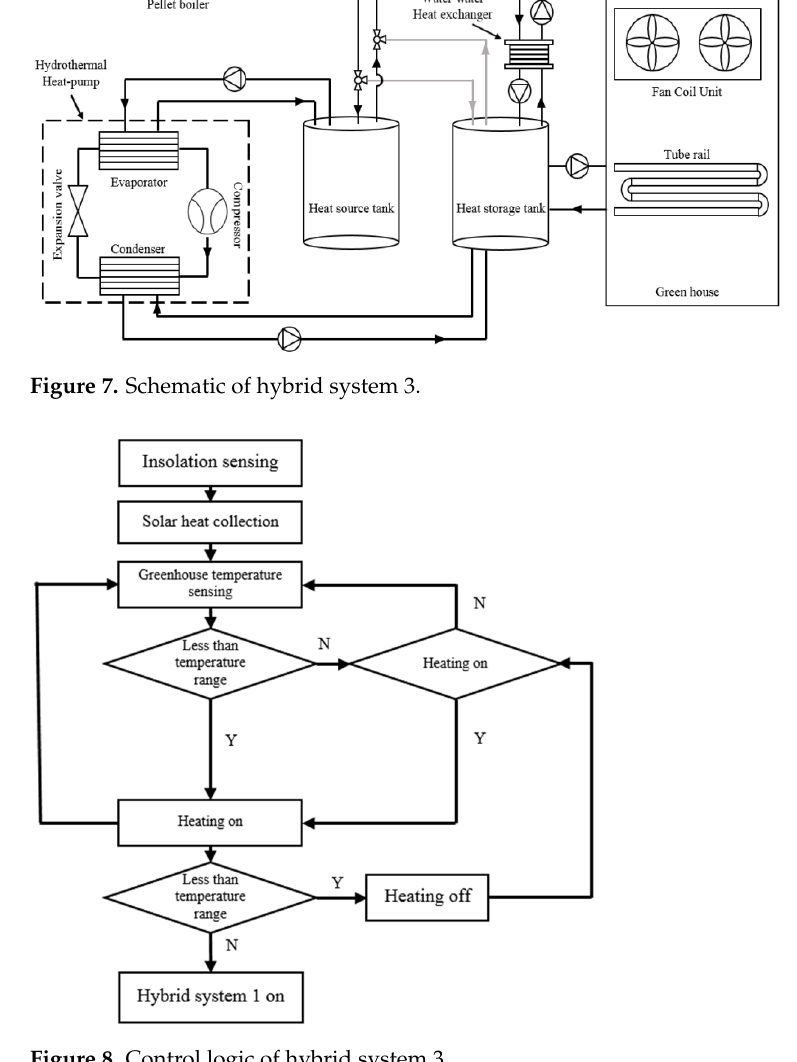
Figure 8. Control logic of hybrid system 3.